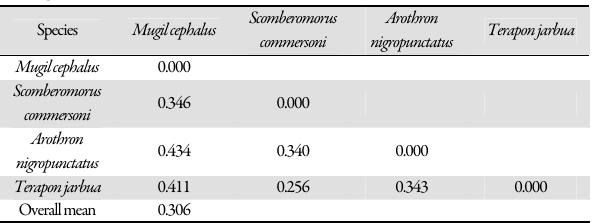
Table 1. K2P genetic distance within species (bold) and between species among the four fish larvae based on CO1 sequence data Species Mugil cephalus